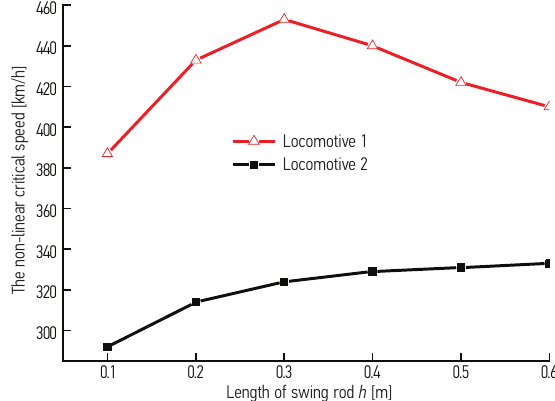
Fig. 24. The simulation results of locomotive 2 when the k c is 0 kN/mm